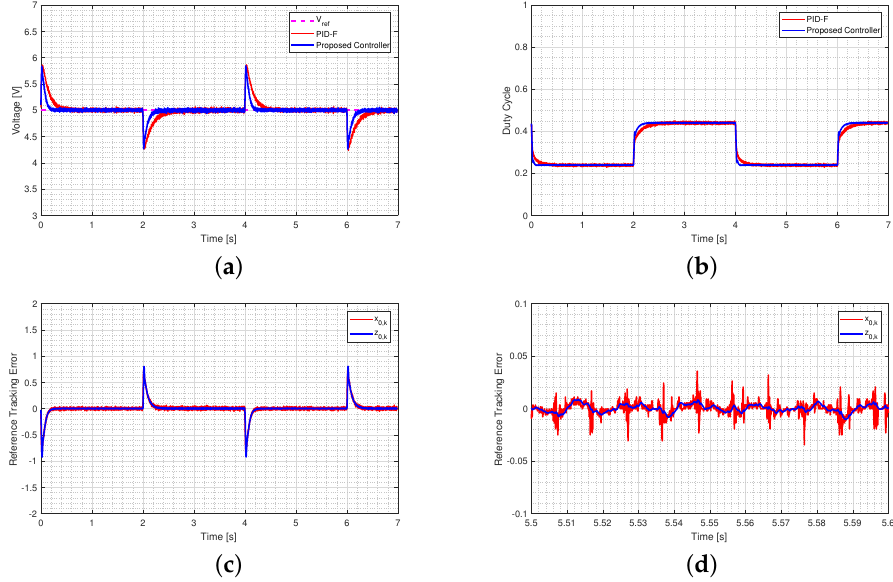
Figure 6. Load variation performance of the proposed controller and a saturated discrete − time PID with τ = 25 µ s. ( a ) Output voltage and reference; ( b ) control output; ( c ) reference tracking error and its estimation; ( d ) reference tracking error detail.